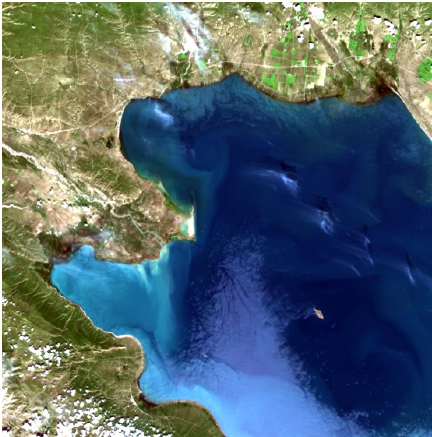
Figure 2. MWI image of Qinghai Lake (Colour synthesis with band 7, band 5 and band 3)